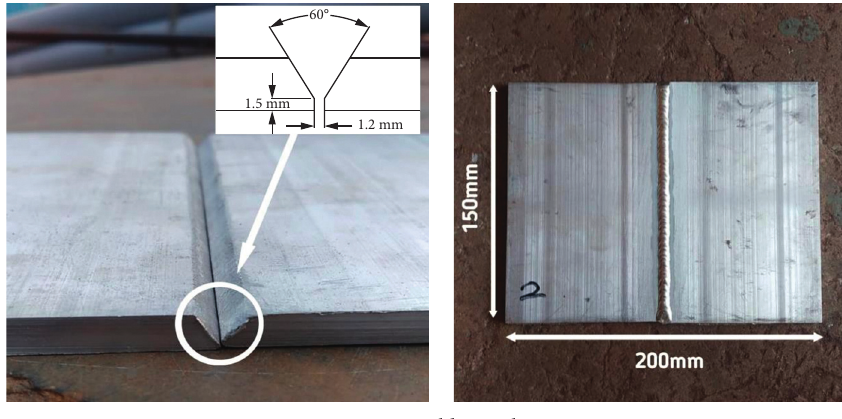
Figure 2: Weld samples.